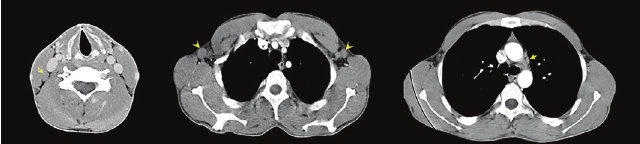
Figure 3 - Lymph nodes in the neck, mediastinum (arrows) and Lymphadenopathies in the axillary region (arrow